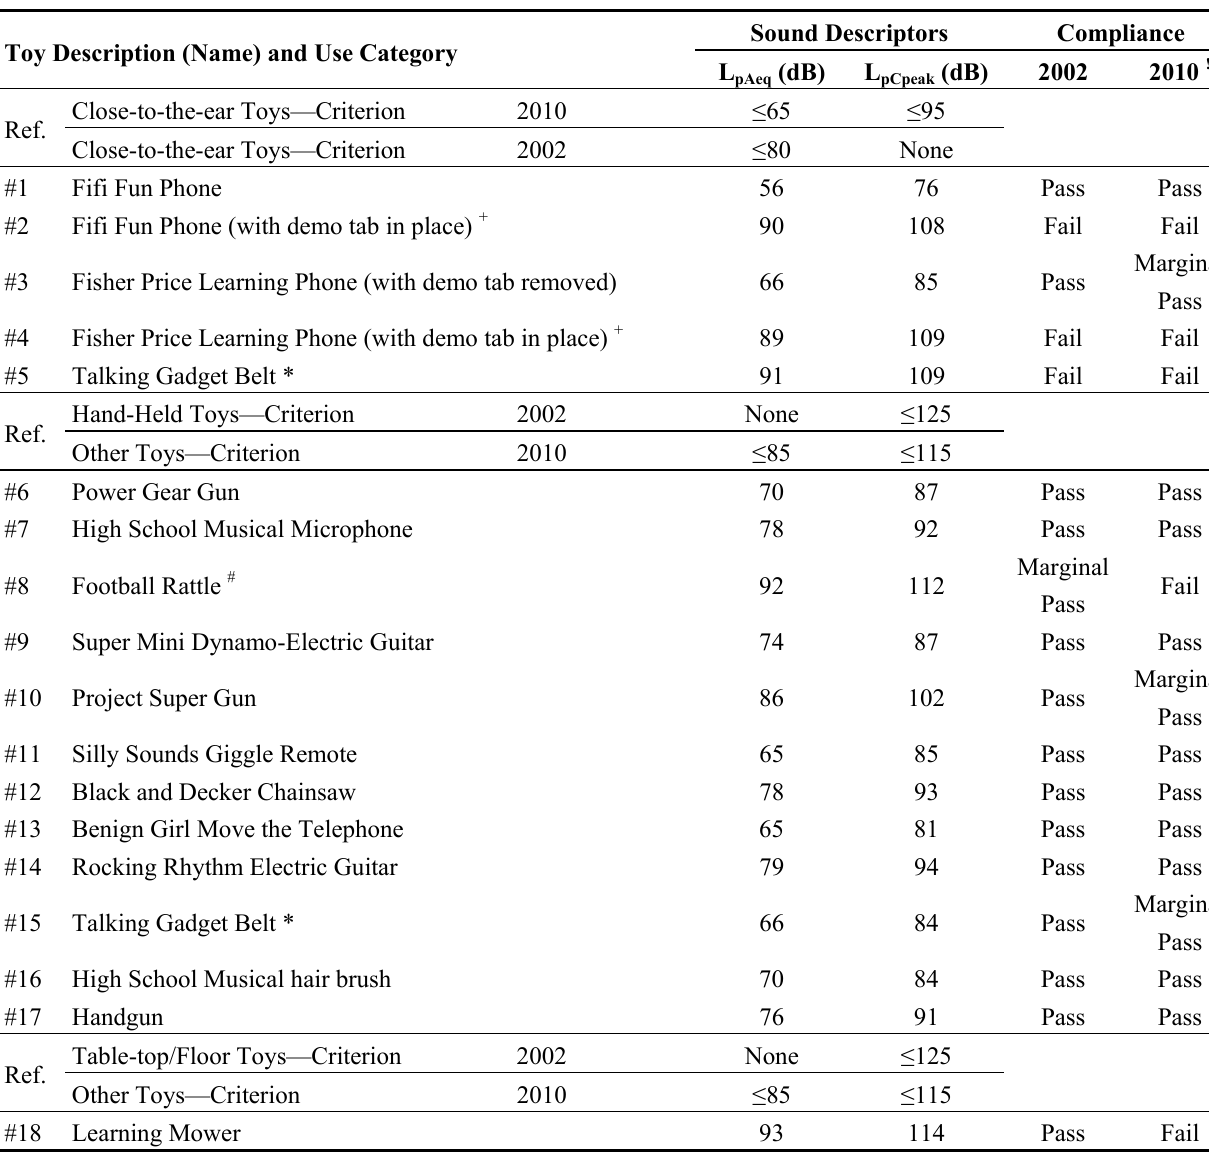
Table 3. Results of testing to the AS/NZS ISO 8124.1:2010 standard and the earlier 2002 standard.